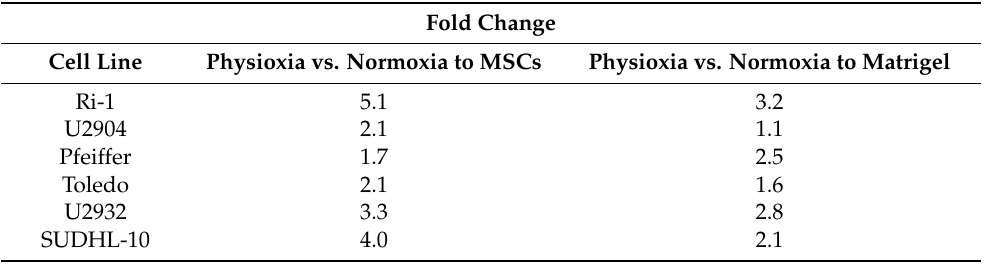
Figure 4. Box and whiskers plot of adhesion changes of single lymphoma cells to mesenchymal stromal cells ( A ) and Matrigel ( B ) when exposed to physioxia for 96 h. A significant difference between single lymphoma cells adhesion in normoxia and physioxia considering a p -value < 0.001 were observed for all cases except U2904 cells adhesion to Matrigel. The symbol ( ◦ ) indicates outliers; Student’s t -test. Table 2. Fold change in time-dependent adhesion to mesenchymal stromal cells ( A ) and Matrigel ( B )